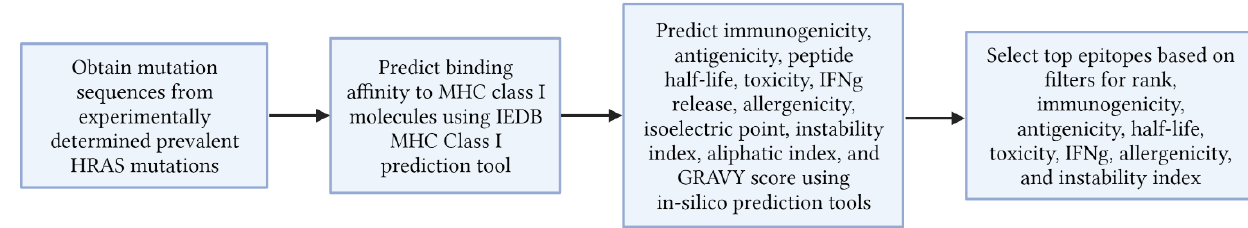
Figure 1. Overall flow of procedures to collect and filter epitope data. Once mutation data is obtained, MHC class I epitope data can be collected from various listed sources. Epitopes can then be filtered to select for clinically viable top epitopes.